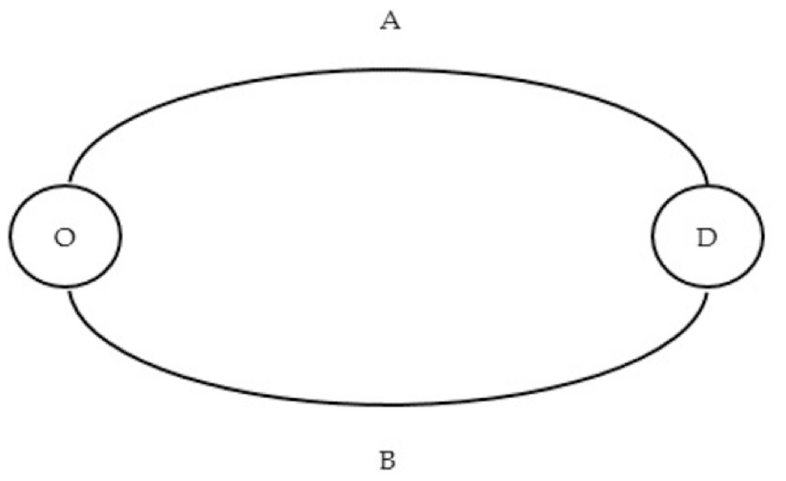
Fig 1. Hypothetical traffic